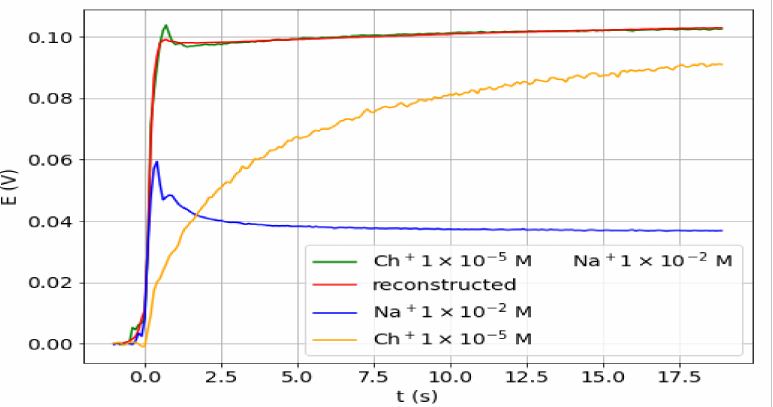
Figure 4. Transient signals obtained for 1 × 10 − 5 M Ch + alone (yellow) and in the presence of 1 × 10 − 2 M Na + (green), and for 1 × 10 − 2 M Na + (blue). Reconstructed signal for the mixture from PCs (red).